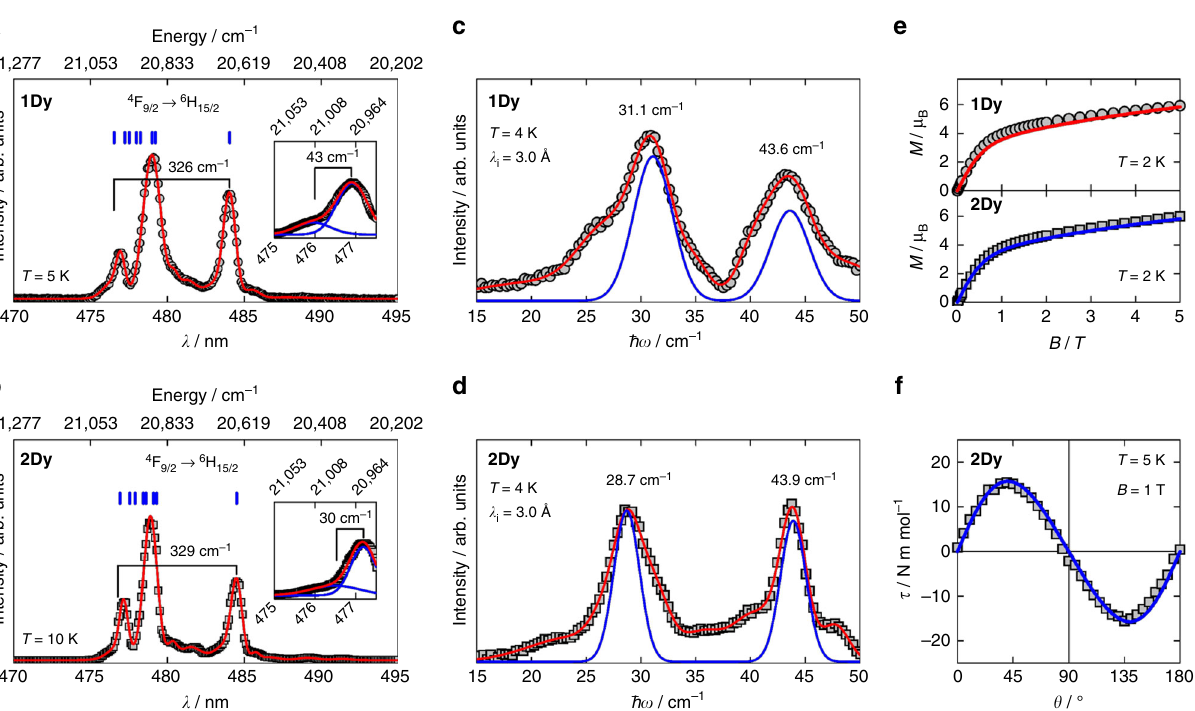
Fig. 3 Crystal fi eld quanti fi cation. Low-temperature luminescence spectra ( 4 F 9/2 → 6 H 15/2 ) for 1Dy ( a , T = 5 K) and 2Dy ( b , T = 10 K) recorded with excitation wavelengths of λ ex = 386 and 387 nm, respectively. For 1Dy ( 2Dy ) the red line is a fi t to a sum of 9 (11) Gaussians, and the vertical blue lines denote the positions of the Kramers doublets within the 6 H 15/2 ground multiplet. The insets give high-resolution spectra of the two peaks at highest energy, with best fi ts to a sum of two Gaussians. INS spectra (integrated over 0.95 Å − 1 ≤ Q ≤ 1.8 Å − 1 ) for 1Dy ( c ) and 2Dy ( d ) at T = 4 K recorded with an incident neutron wavelength of λ i = 3.0 Å. For 1Dy ( 2Dy ) the red line is a fi t to a sum of 7 (8) Gaussians. The blue lines are the simulated INS spectra based on CF parameters in Table 1. In c and d , the errors are less than the size of the symbols. Powder-averaged molar magnetization for 1Dy ( e , top) and 2Dy ( e , bottom) at T = 2 K, with lines indicating the best fi ts. Molar magnetic torque of a single crystal of 2Dy ( f ) at T = 5 K recorded in an applied magnetic fi eld of B = 1 T. θ denotes the angle (increasing anticlockwise) between the crystallographic ab plane and the applied magnetic fi eld. The blue line represents the angular dependence of the magnetic torque simulated from the CF parameters for 2Dy given in Table 1